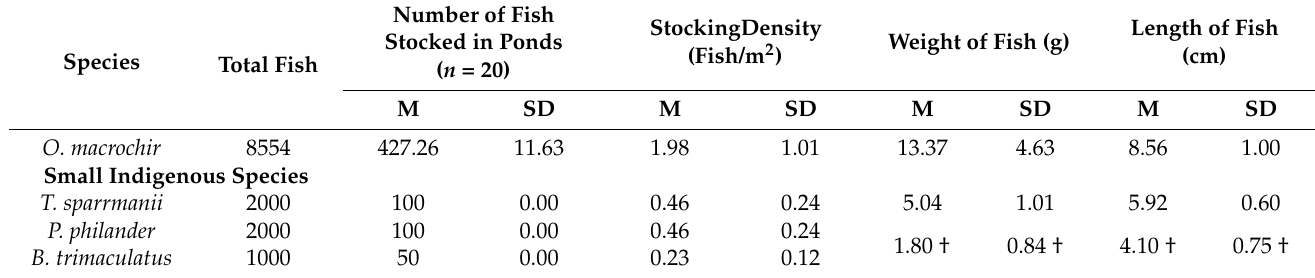
Table 1. Stocking data for polyculture trial including one commercial tilapia species ( O. macrochir ) and three Small Indigenous Species